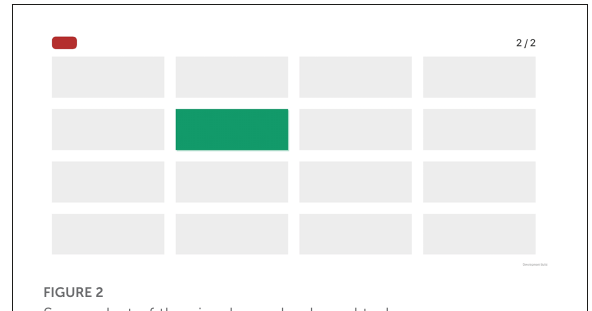
FIGURE2 Screenshot of the visual span backward task.